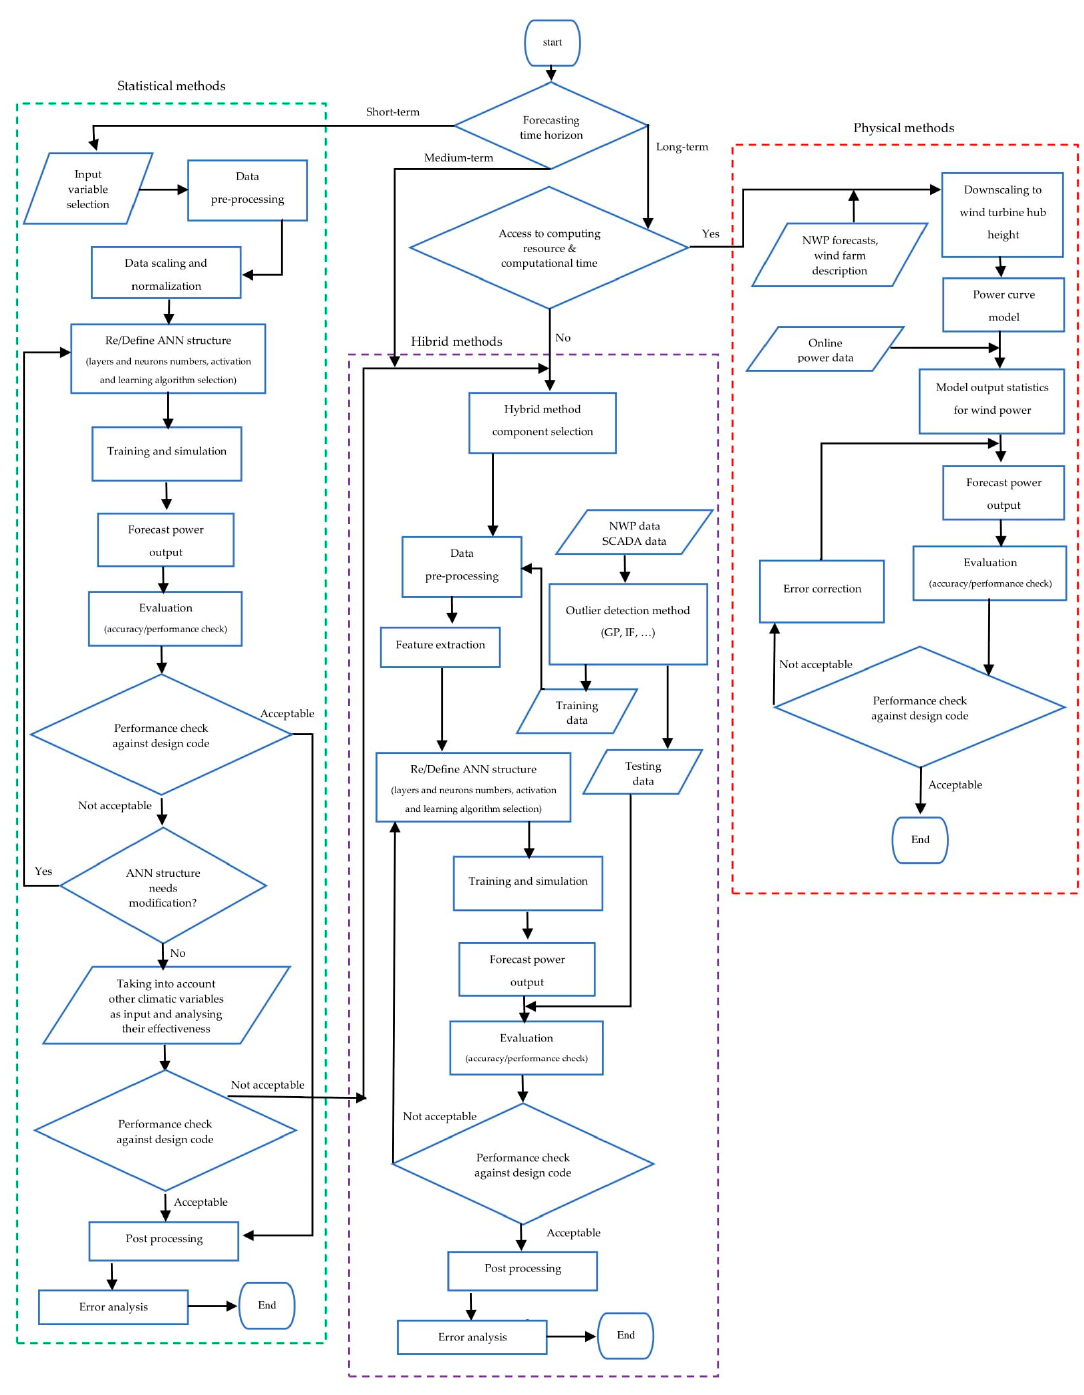
Figure 5. Flowchart of model selection in wind power forecasting.